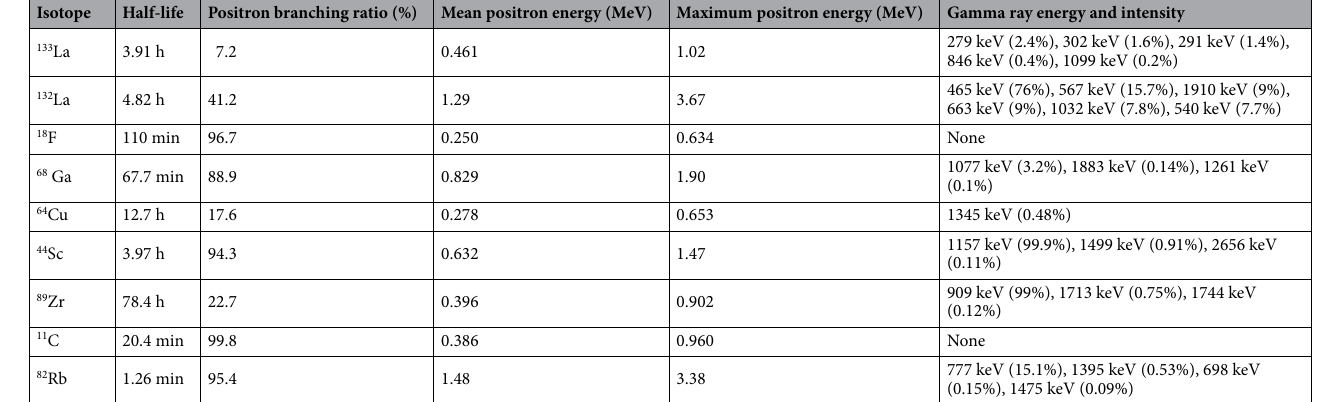
Table 5. Positron decay characteristics and notable gamma rays for 133 La, 132 La, and other common PET isotopes 9